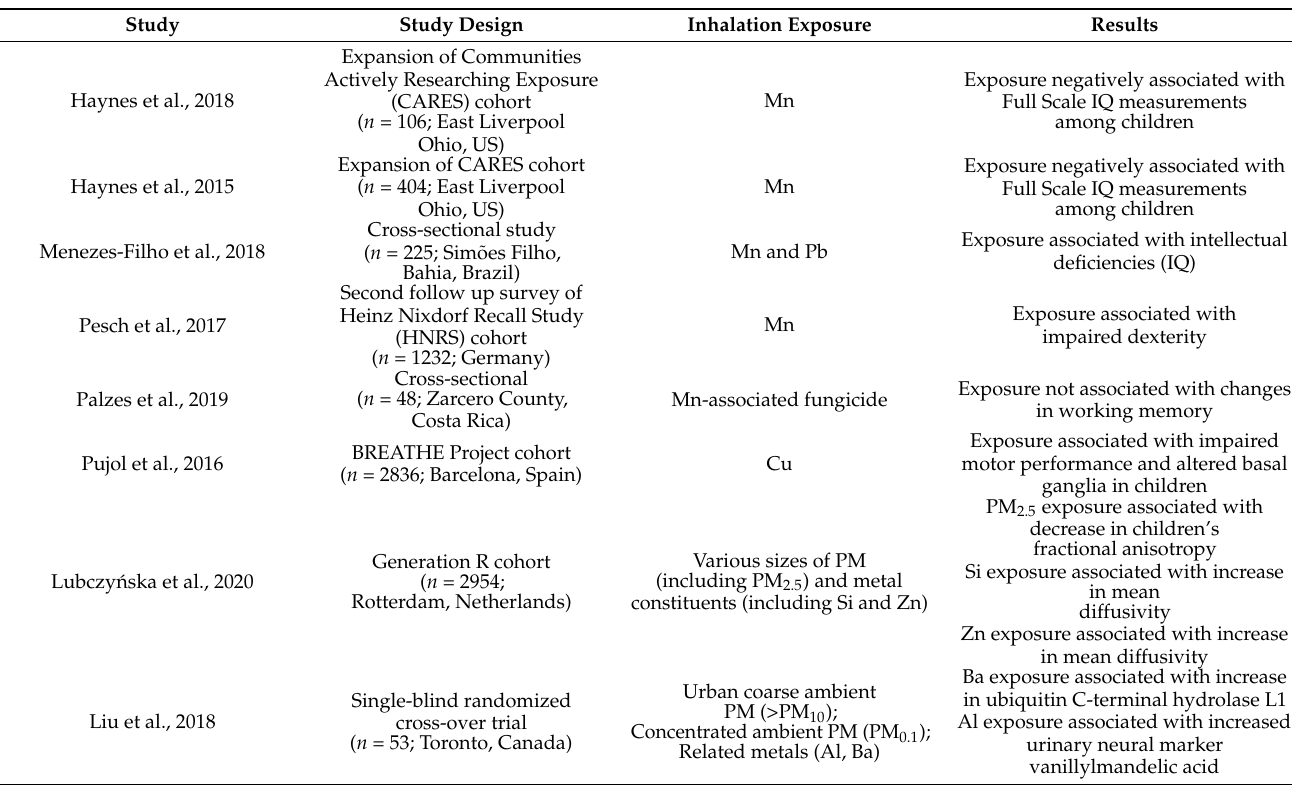
Table 1. Summary of epidemiological studies on particulate matter (PM) and associated metals and their effects on brain